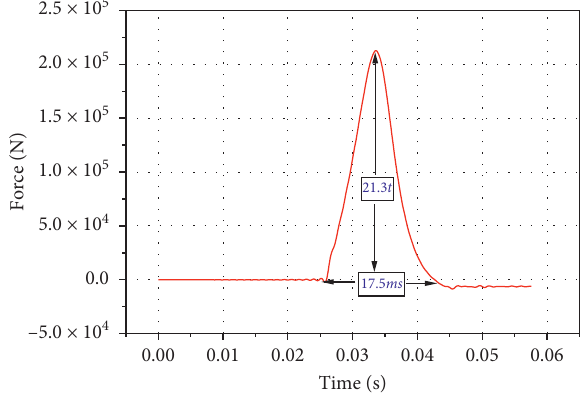
Figure 8: Typical time history of tested force.